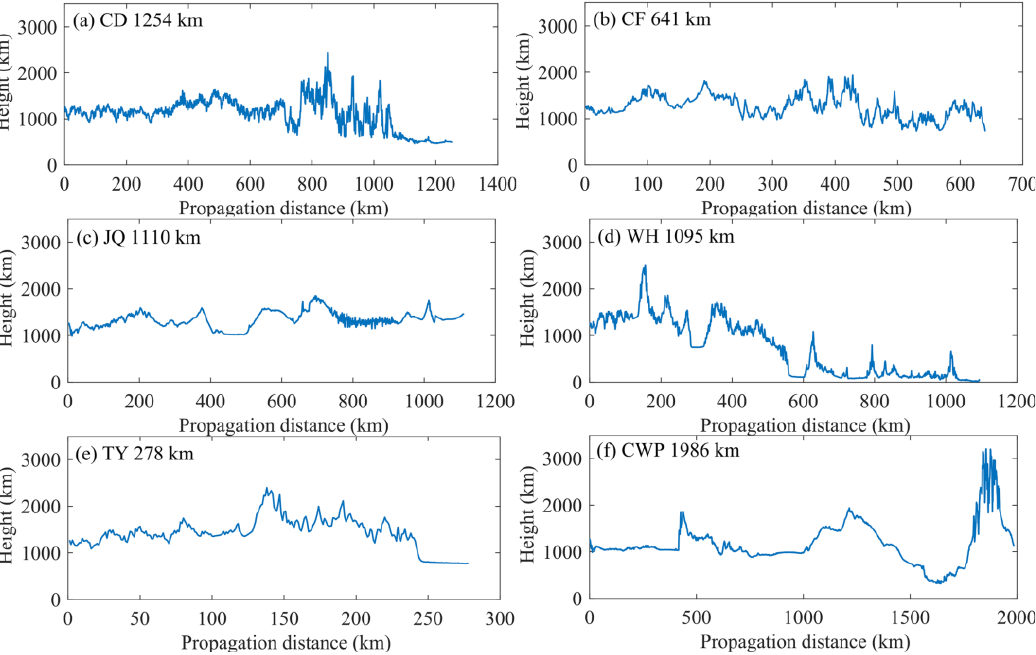
Figure 12. ( a – f ) Vertical topographic profiles from the source to the following sensors: CD, CF, JQ, WH, TY and CWP.